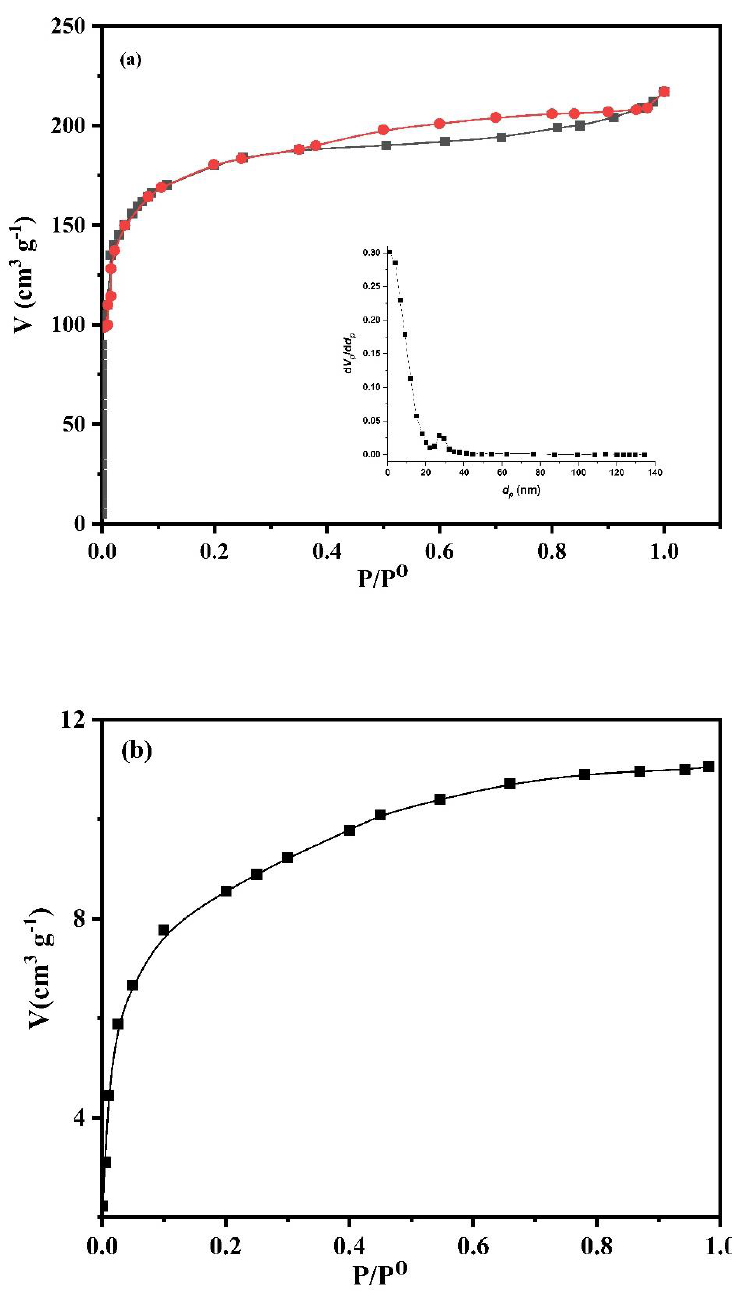
Figure 4. Nitrogen gas adsorption/desorption isotherm for ( a ) the activated carbon sample (inserted BJH plot) and ( b ) the native rice husk at − 196 °C. BJH plot) and ( b ) the native rice husk at − 196 ◦